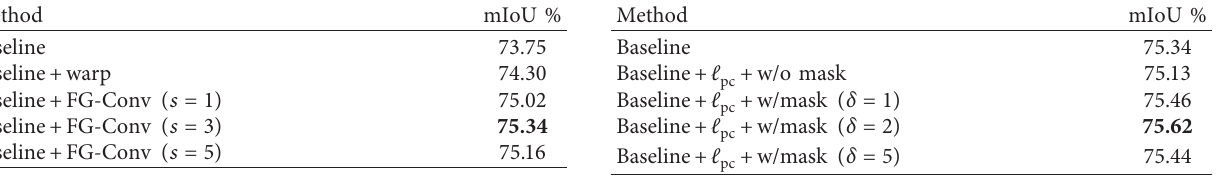
Table 3. We first try the prediction consistency loss without the